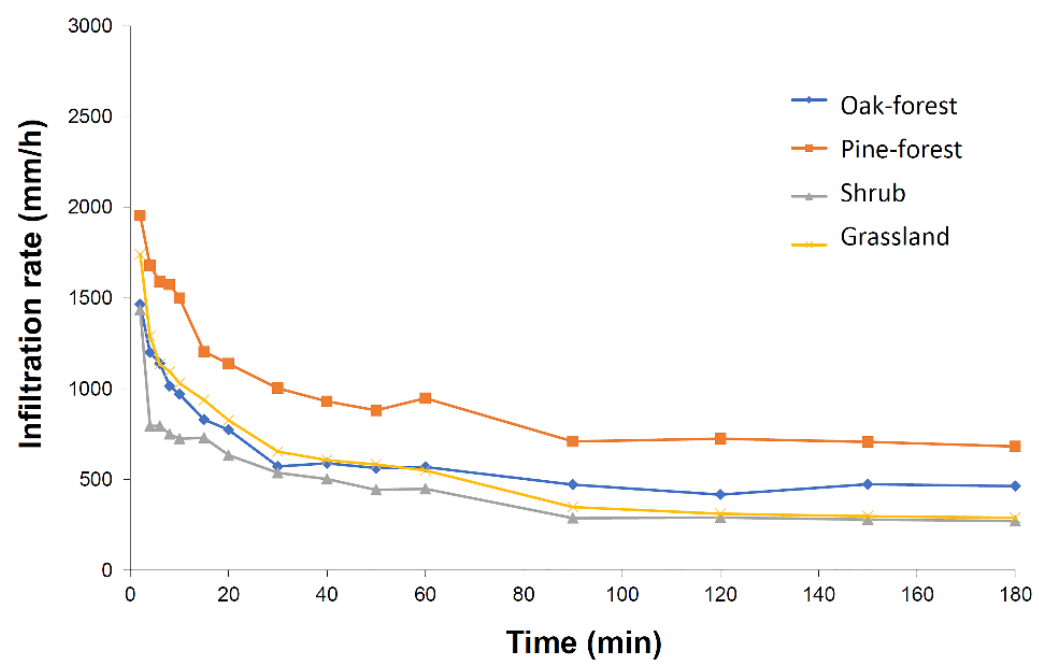
Figure 6. Infiltration curves for the four types of vegetation zones.